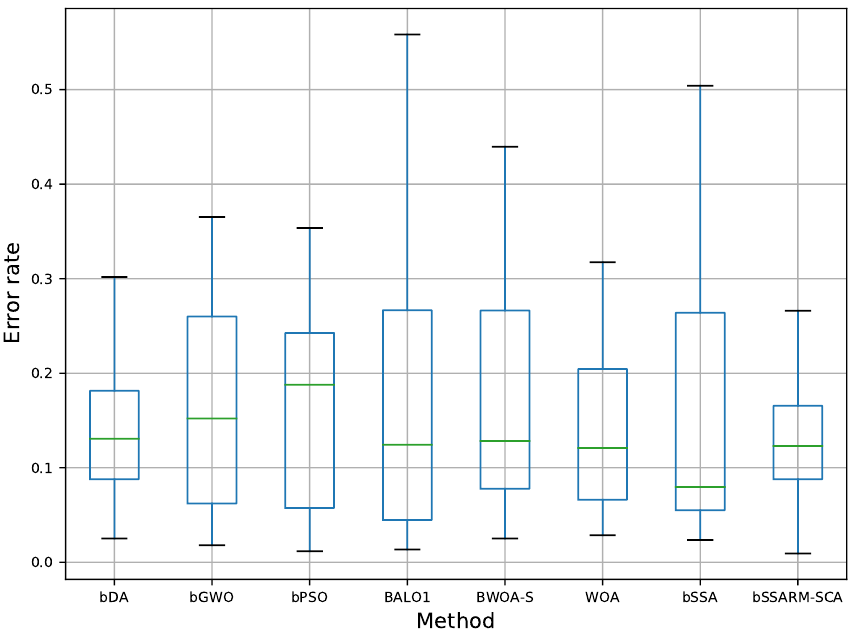
Figure 3. Box plots and whiskers diagrams for average error rate including all datasets and three initialization strategies. Table 17. Classification accuracy of the proposed bSSARM-SCA method and three recent ISSA variants for the 21 utilized